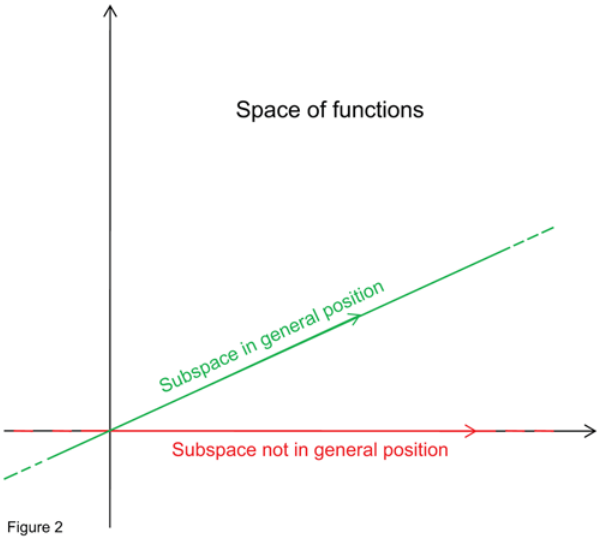
Figure 2. The notion of general position. A two-dimensional representation of the space of functions F n F q (cid:4) (cid:5) . Within this space, two one-dimensional subspaces are depicted. One subspace (green) is in general position, while the other one (red) is not.